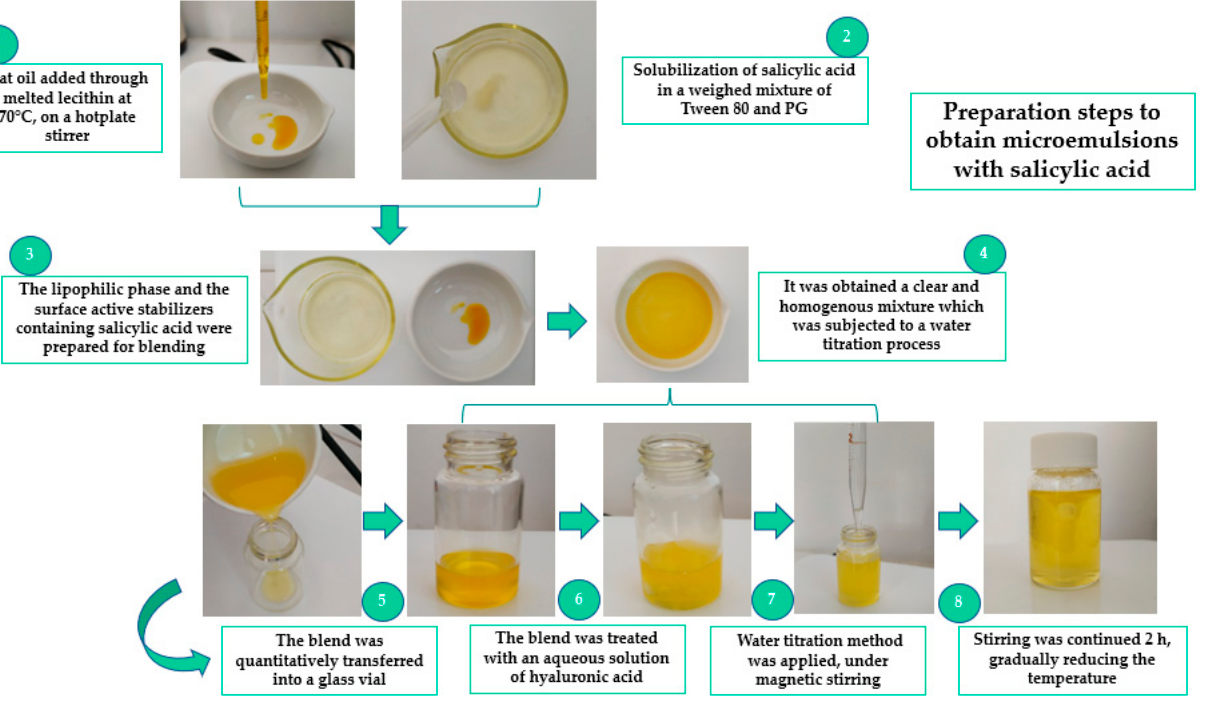
Figure 1. Critical steps performed in the preparation process of microemulsions with salicylic acid.